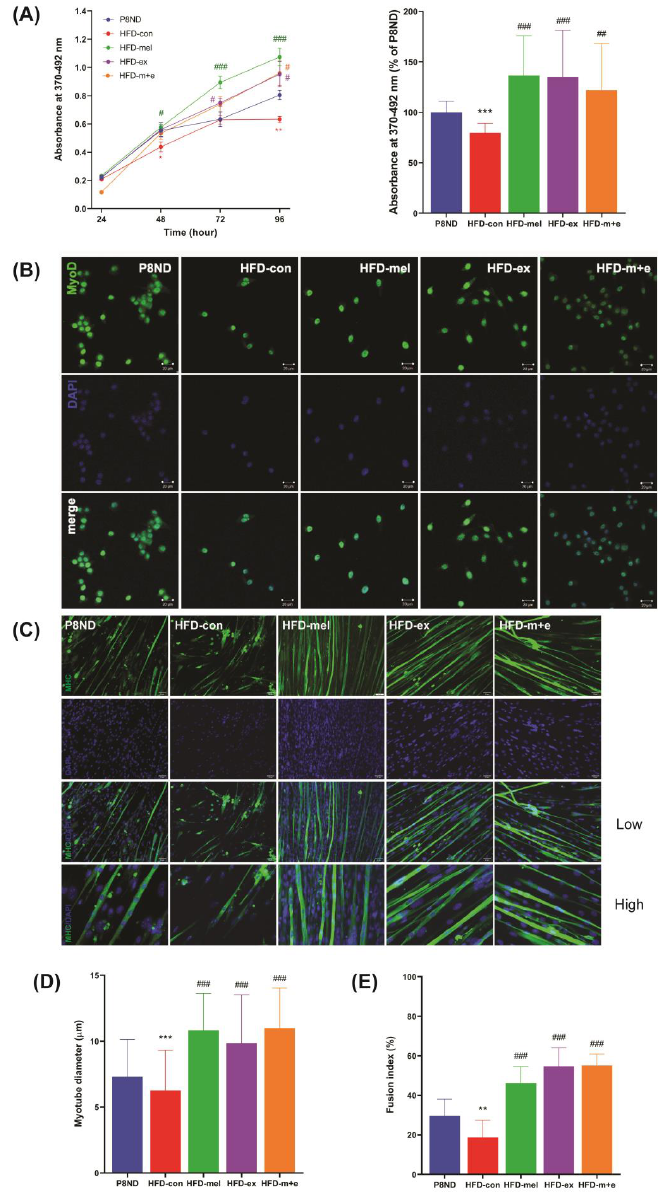
Figure 6. Melatonin and/or exercise training inhibited the HFD-induced deterioration of SC-derived myoblasts’ proliferation and differentiation capacity: ( A ) Cell proliferation capacity was measured by BrdU assay. ( Left ) BrdU labeling was measured during proliferation for 96 h. Data are the mean ± SD (n = 3 mice per group); * p < 0.05, ** p < 0.01 vs. P8ND; # p < 0.05, ### p < 0.001 vs. HFD-con, using a two-way ANOVA and Dunnett’s multiple comparisons test. ( Right ) Bar graph illustrating the absorbance at 96 h after proliferation; *** p < 0.001 vs. P8ND; ## p < 0.01 and ### p < 0.001 vs. HFD-con, by unpaired t -test. ( B ) The number of proliferating cells after 72 h was determined by immunofluorescence. A representative immunofluorescent image of MyoD staining detected by a species-specific antibody conjugate with Alexa Fluor 488 (green) and DAPI (blue) nuclear staining is shown. Scale bar = 20 µ m. ( C ) SC-derived primary myoblasts were induced to differentiate for 7 days and stained with an antibody for MHC, followed by a species-specific antibody conjugate with Alexa Fluor 488 (green) and DAPI for DNA (blue). Scale bar = 50 µ m. Images with both low and high magnification were merged and displayed. ( D ) Myotube diameter and ( E ) fusion index were calculated. Data are the mean ± SD (n = 3 mice per group); ** p < 0.01 and *** p < 0.001 vs. P8ND; ### p < 0.001 vs. HFD-con, by unpaired t